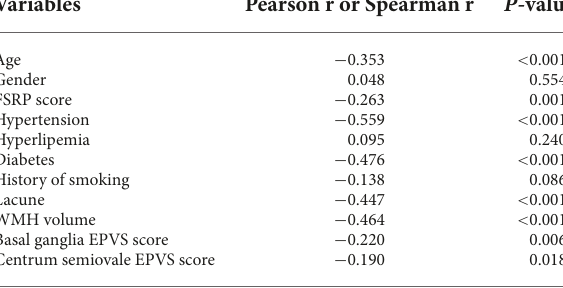
TABLE 4 Relationship between ALPS-index and VRFs and CSVD imaging features.